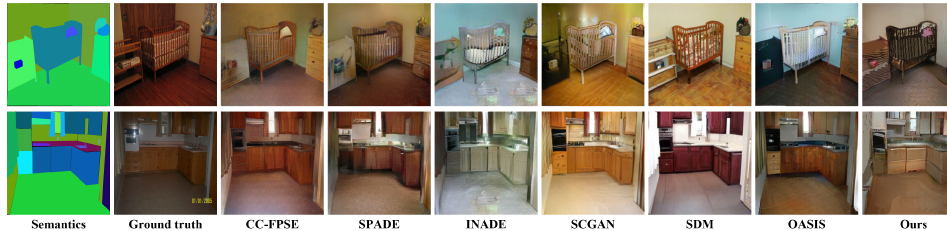
Figure 8. Quality comparison between the best proposed model (ResNet-ED+Add) and SOTA methods in image synthesis on ADE20K indoor subset; the methods in the comparison are CC- FPSE [27], SPADE [10], INADE [11], SCGAN [24], SDM [14], and OASIS